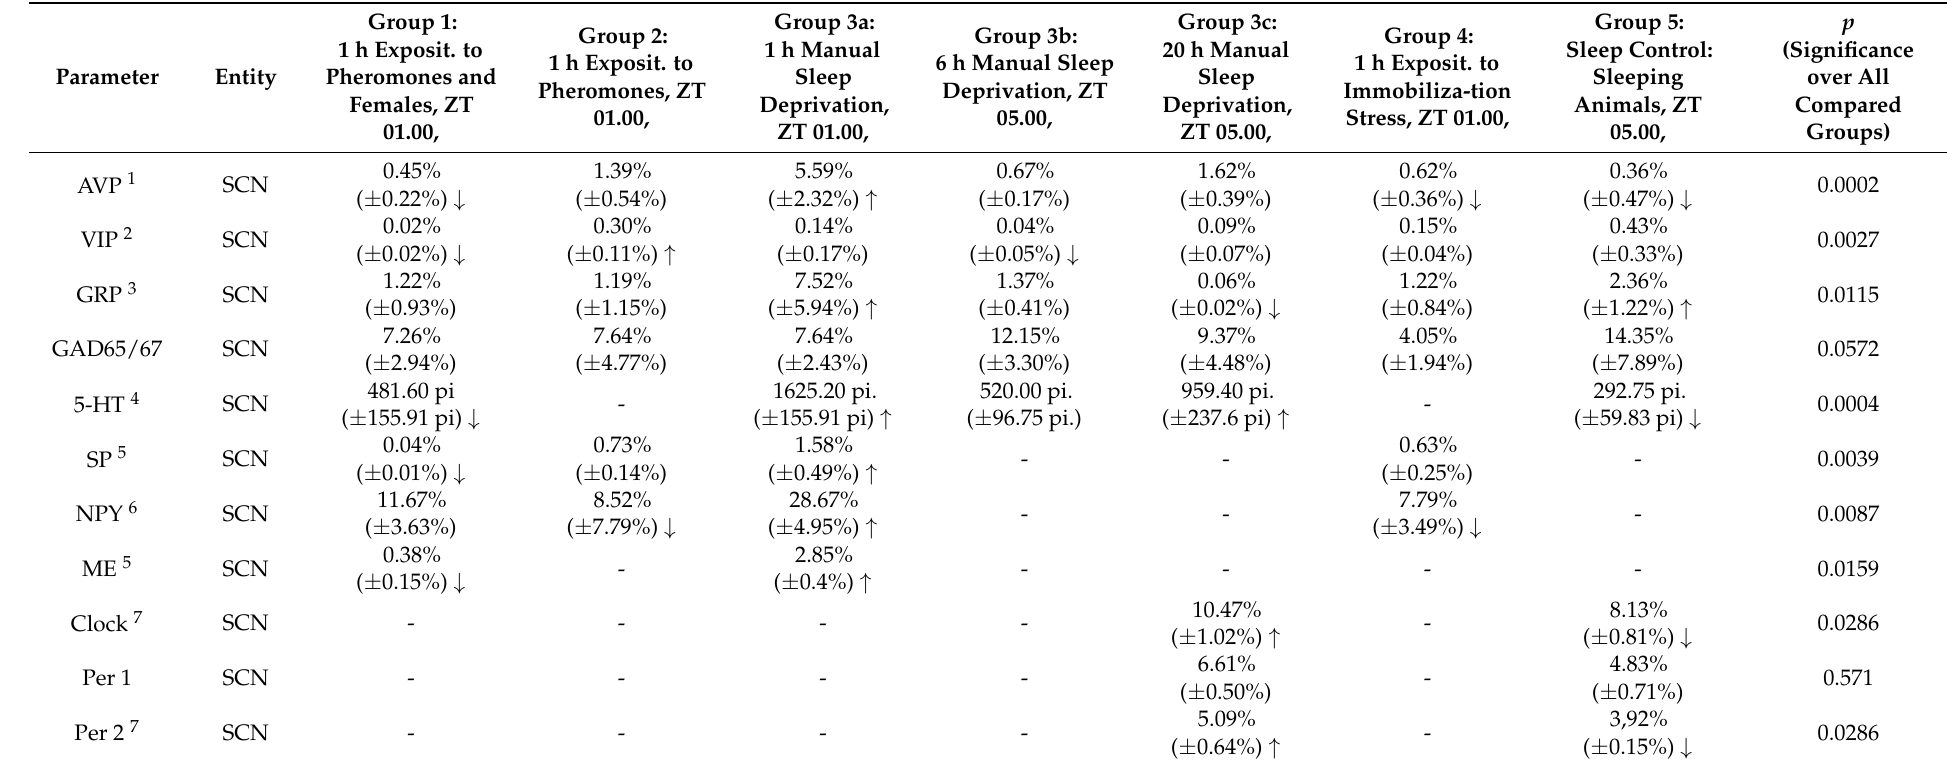
Table 2. Effects of sleep deprivation caused by sexual arousal (group 1), pheromone-only based stimulation (group 2), gentle manual handling for 1 h (group 3a), 6 h (group 3b), and 20 h (group 3c), respectively, immobilization stress (group 4) versus a control group of hamsters sleeping ad libitum (group 5) on neuropeptides, time-keeping proteins, steroid receptors, guiding enzymes for the synthesis of neurotransmitters as well as the neurotransmitter serotonin and the steroid testosterone in sexually naïve male Syrian hamsters. 5-HT = serotonin (5-hydroxy-tryptophan), AR = androgen receptor, AVP = arginine-vasopressin, Cry = cryptochrome, DBH = dopamine beta-hydroxylase (the guiding enzyme of norepinephrine synthesis), GAD-65/67 = glutamate dehydrogenase (the guiding enzyme of GABA synthesis), GRP = gastrin-releasing peptide, ME = met-enkephalin, NPY = neuropeptide Y, OR = estrogen receptor, OXY = oxytocin, PER = period, pi = pixels, SOM = somatostatin, SP = substance P, TH = tyrosine hydroxylase (the guiding enzyme of dopamine synthesis),VIP = vasoactive intestinal polypeptide. ↓ = p < 0.05 for decrease compared to at least one other experimental group, ↑ = p < 0.05 for decrease compared to at least one other experimental group. A7 = A7 neuron population of the brain stem, DRN = dorsal raphe nucleus, IN = infundibular nucleus, MPOA = medial pre-optic area, MPVN = medial periventricular nucleus, PVN = paraventricular nucleus, SCN = suprachiasmatic nucleus, SON = supraoptic nucleus. ZT = zeitgeber time. - = data missing. Data are provided as mean values ± standard